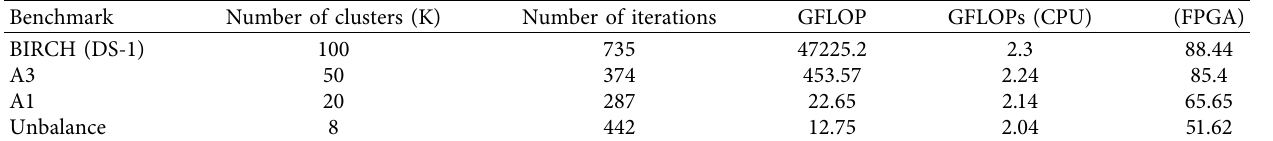
Table 3: GFLOPs performance